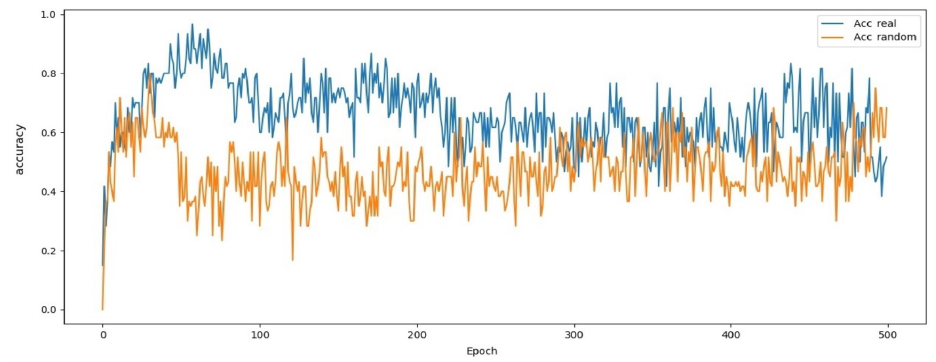
Figure 6. The discriminator’s accuracy over